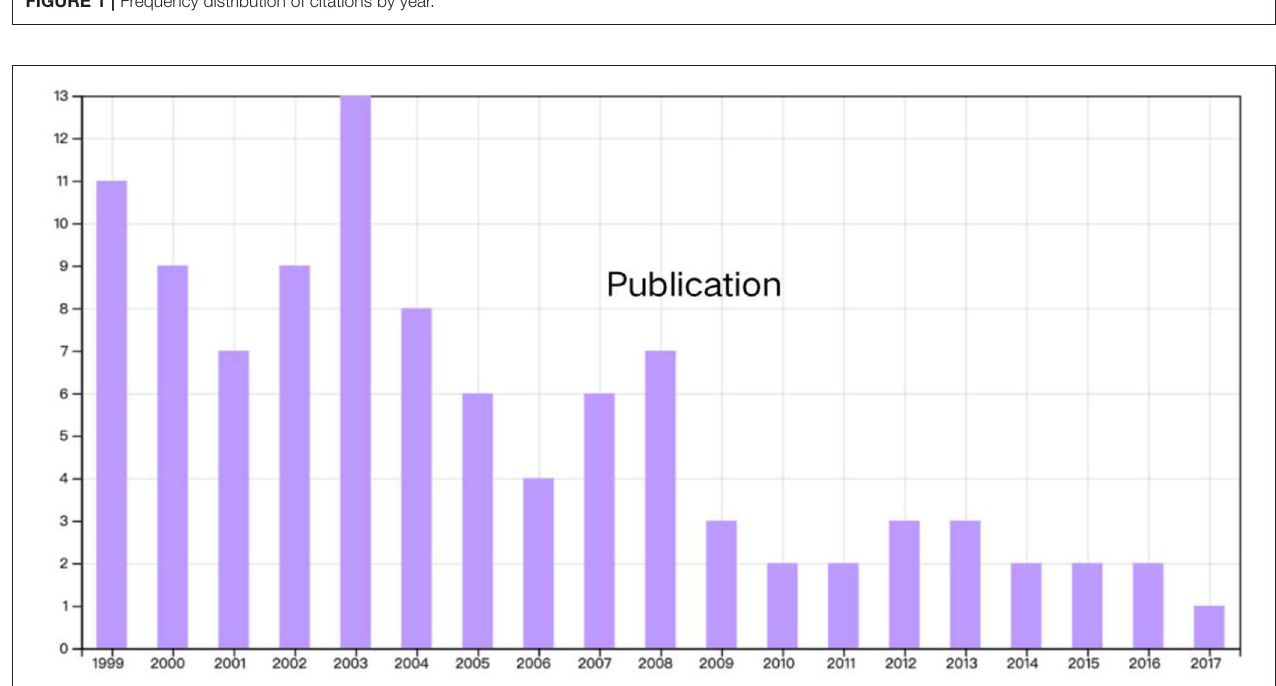
FIGURE 1 | Frequency distribution of citations by year.